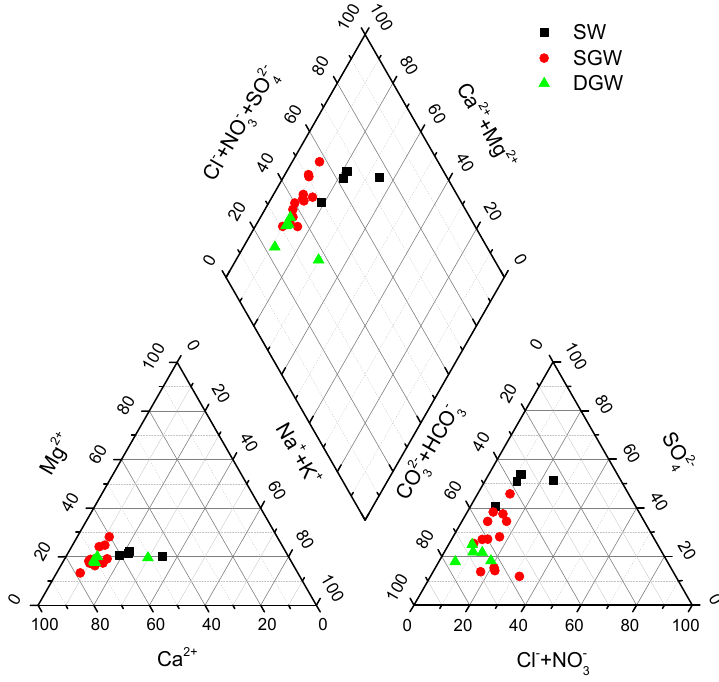
Figure 3. Piper diagram of water samples. (SW: Surface water; SGW: Shallow groundwater; DGW: Deep